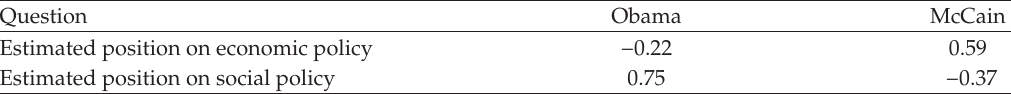
Table 7: Obama and McCain perceived